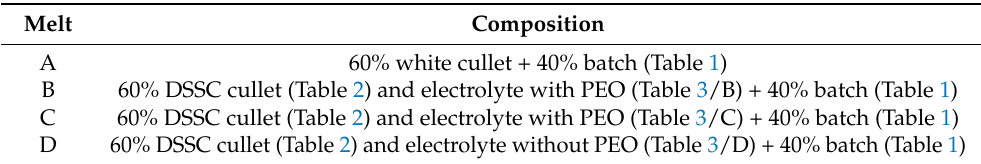
Table 4. Overview of the composition of each melt. Melt